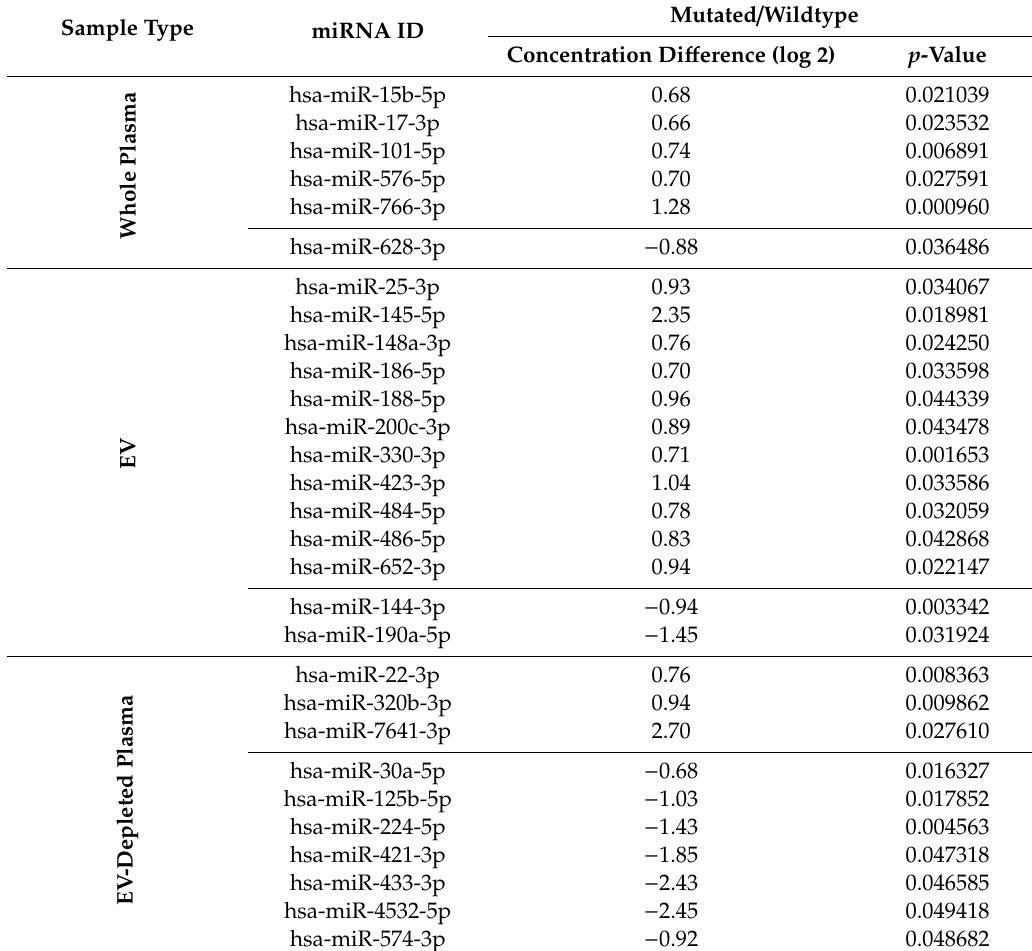
Table 3. miRNAs showing concentration a ff ected by RNF213 mutations among MMD patients. Sample